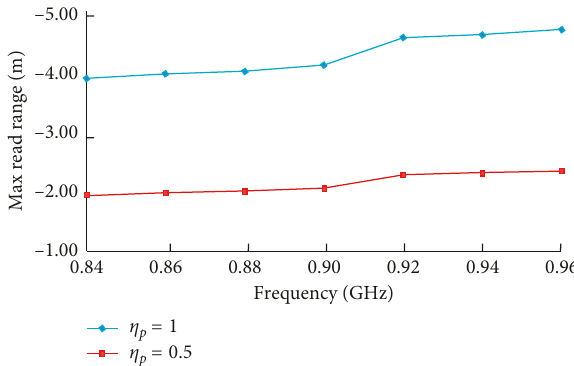
Figure 8: Read range of the epidermal RFID double-loop tag with meandered line in the horizontal direction.